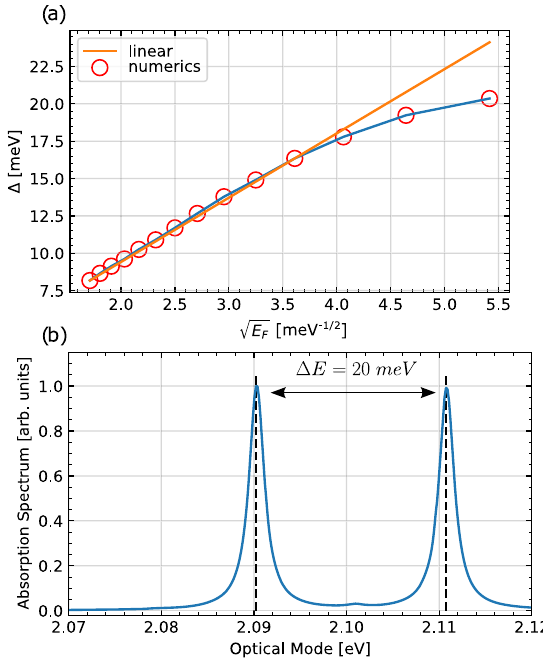
Fig. 6 Trion-polariton properties. a Trion polariton energy splitting as a function of the square root of electron density (red circles and blue curve). We con fi rm the linear increase of splitting at low densities E F ≤ 16.5 meV (cf. orange line). However, at large free electron densities, we see the growth becomes sublinear in b Intensity pro fi le for polaritonic spectrum at large doping ( E F = 29.34 meV). The cavity mode energy is tuned to 2.11 eV, being in resonance with the trion mode. The fi rst two consecutive peaks correspond to trion-polaritons, with the Rabi splitting of 18 meV.